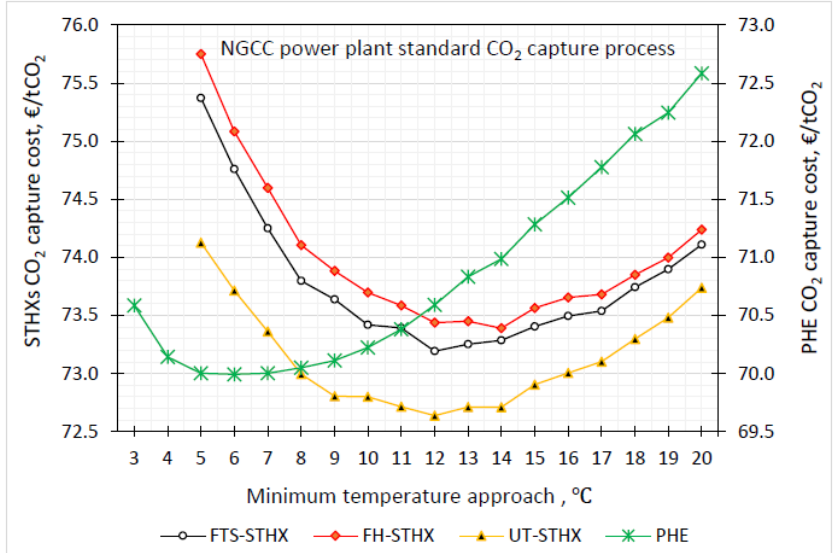
Figure 7. Energy and heat exchanger costs trade-off analysis at different ∆ T min for different heat exchanger types in a standard CO 2 capture from NGCC power plant exhaust gas.